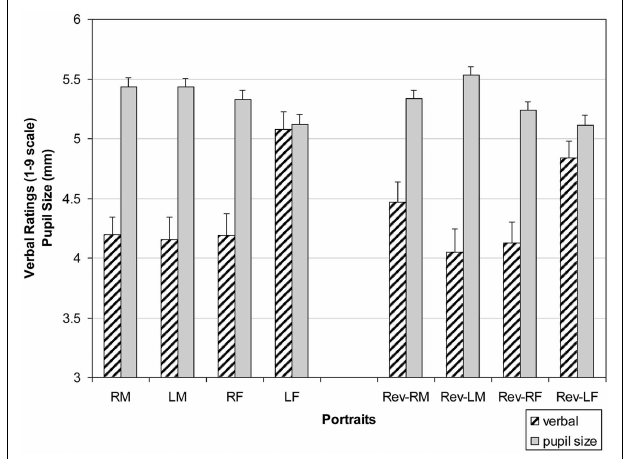
FIGURE 4 |Verbal ratings (striped bars) as a function of portrait type on a 1–9 scale, with 1 indicating most displeasing, 5 indicating neutral, and 9 indicating most pleasant . Pupil size in mm (solid bars) as a function of portrait type (R = Right-cheeked, L = Left-cheeked, M = Males, F = Females, Rev = Mirror-reversed images). Error bars = SEM.